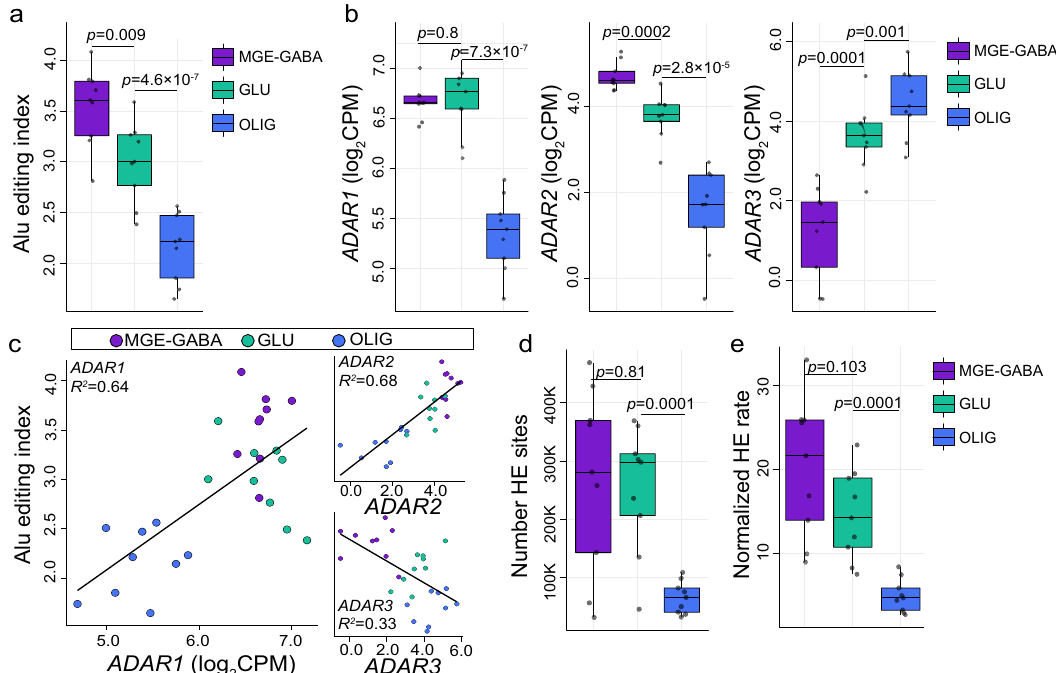
Fig. 1 Global selective editing and hyper-editing in puri fi ed cortical cell types. a The Alu editing index (AEI) (y-axis) and b normalized expression for ADAR1 , ADAR2 , and ADAR3 (y-axis) measured for each FANS-derived cell population from the human adult prefrontal cortex (PFC, n = 9 biologically independent samples): MGE-GABA, GLU, and OLIG populations. c The amount of AEI variance explained ( R 2 , y-axis) by ADAR expression. d The total number of hyper-editing (HE) sites (y-axis) and e the normalized HE rate (y-axis) across all cell types. All box plots show the medians (horizontal lines), upper and lower quartiles (inner box edges), and 1.5 × the interquartile range (whiskers). The normalized HE rate is de fi ned as the number of HE sites detected per million mapped (MM) bases, computed by dividing the total number of HE sites over the total number of MM bases per sample and multiplying the result by one million. Two-sided linear regression computed signi fi cance in mean differences between MGE-GABA vs. GLU and GLU vs. OLIG. No adjustments were made for multiple comparisons. In all panels, MGE-GABA vs. OLIG were deemed statistically signi fi cant ( p < 0.05). Cohen ’ s d was used as a measure of effect size pertaining to differences in the AEI and HE signal between cell